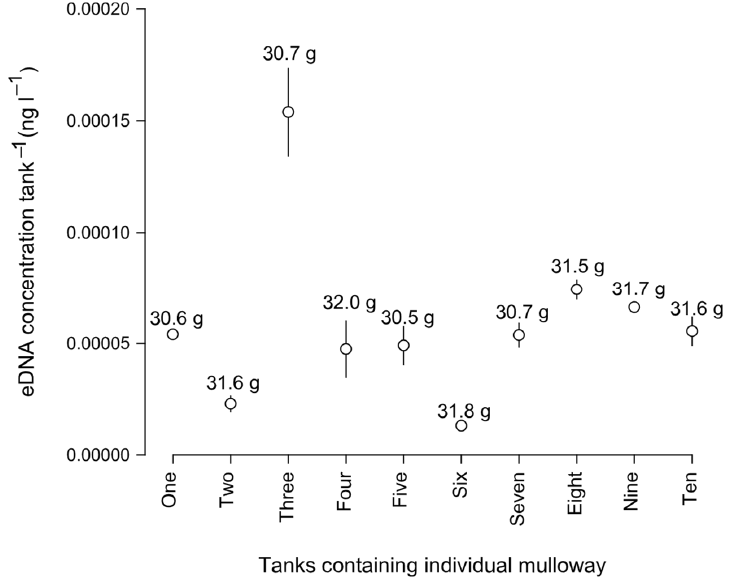
Figure 4. Mean (±SE) eDNA concentrations sampled from 10 identical 16 ‐ l tanks containing individ ‐ ual mulloway, Argyrosomus japonicus (with their weights displayed above each data point) during experiment 4 completed at the Port Stephens Fisheries Institute, New South Wales, Australia during August,